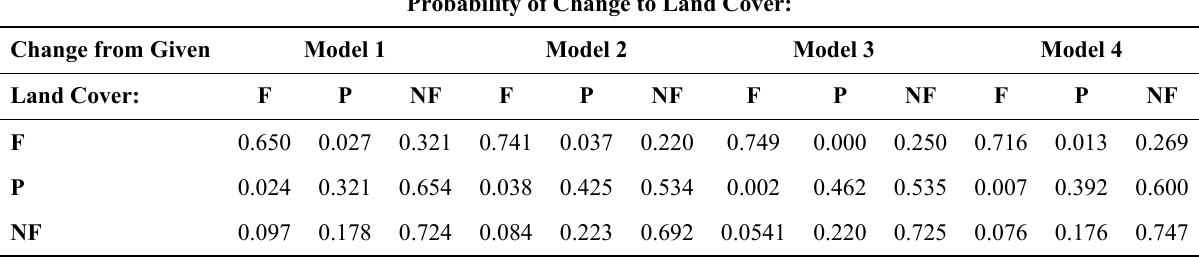
Table 3. Probability of change for four models based on Markov chain analysis. F = Native Forest, P = Tree Plantation and NF =